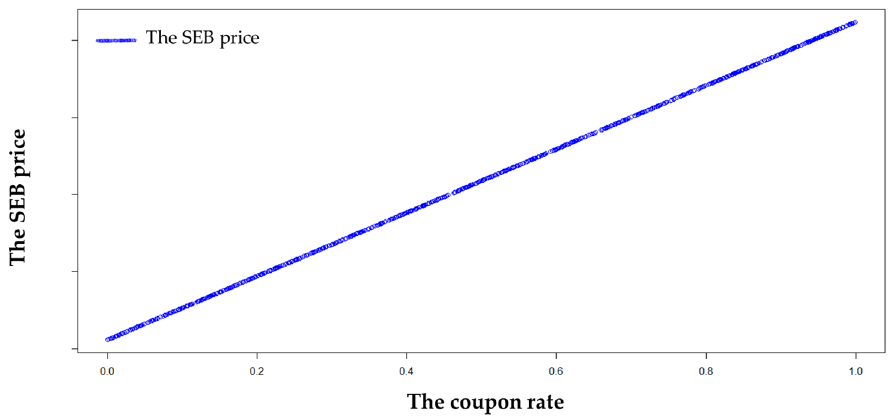
Figure 22. The SEB price based on seismic information in Cluster Type II with FV = IDR 1,000,000, T = 3, A(R (cid:2930) ) = 0.048